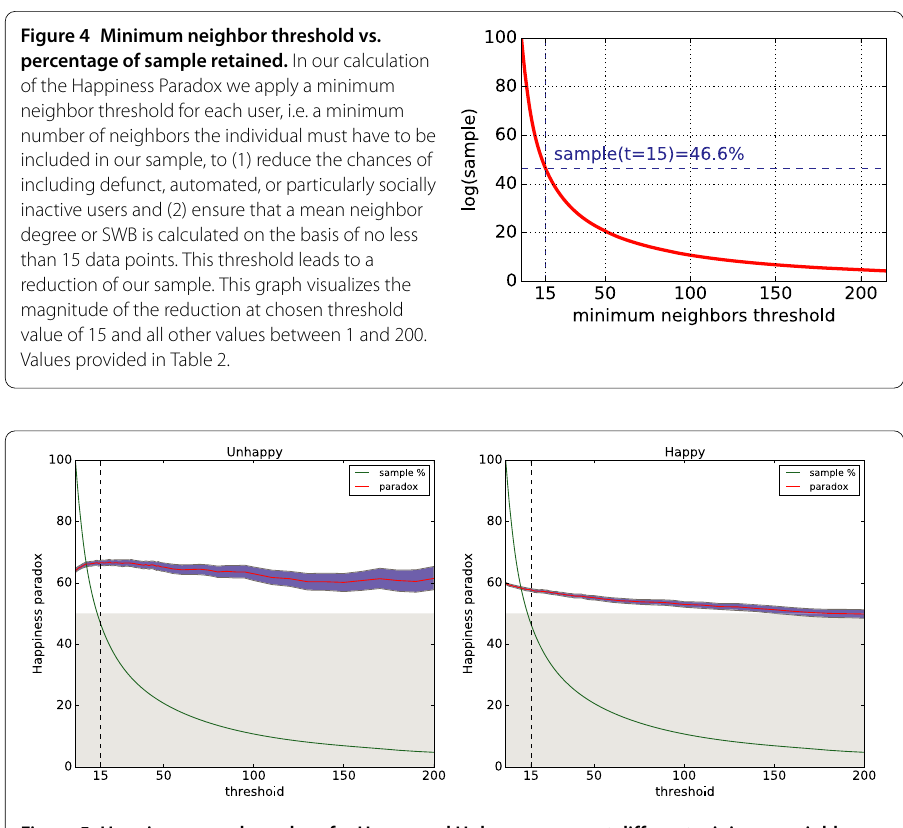
Figure 5 Happiness paradox values for Happy and Unhappy group at different minimum neighbor threshold values, with 95% confidence intervals. Overlayed are the remaining sample size for the same threshold values. The gray area indicates paradox value below 50%, i.e. no happiness paradox. We find a significant happiness paradox, under all but the most extreme values of the minimum neighbor